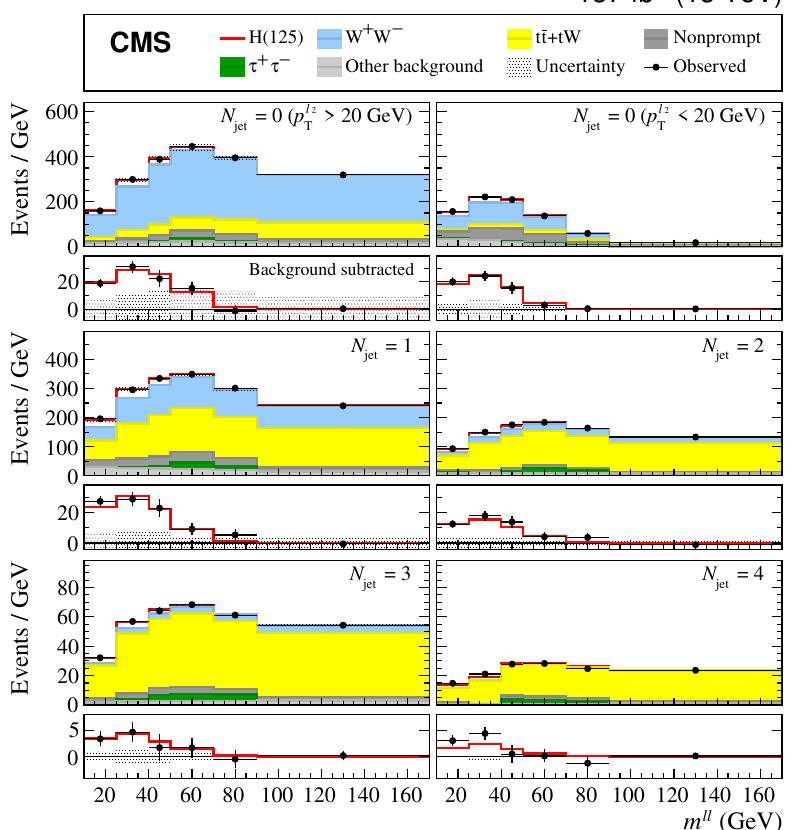
Figure 2 . Observed distributions of m ll in data and the expectations from the best fit model with the uncertainties. The distributions in each N bin are given in separate panels. Within jet each panel, the lower sub-panel displays background-subtracted observations and expectations. For N = 0 , results are split into p l 2 > 20 GeV (left) and p l 2 < 20 GeV (right). jet T T